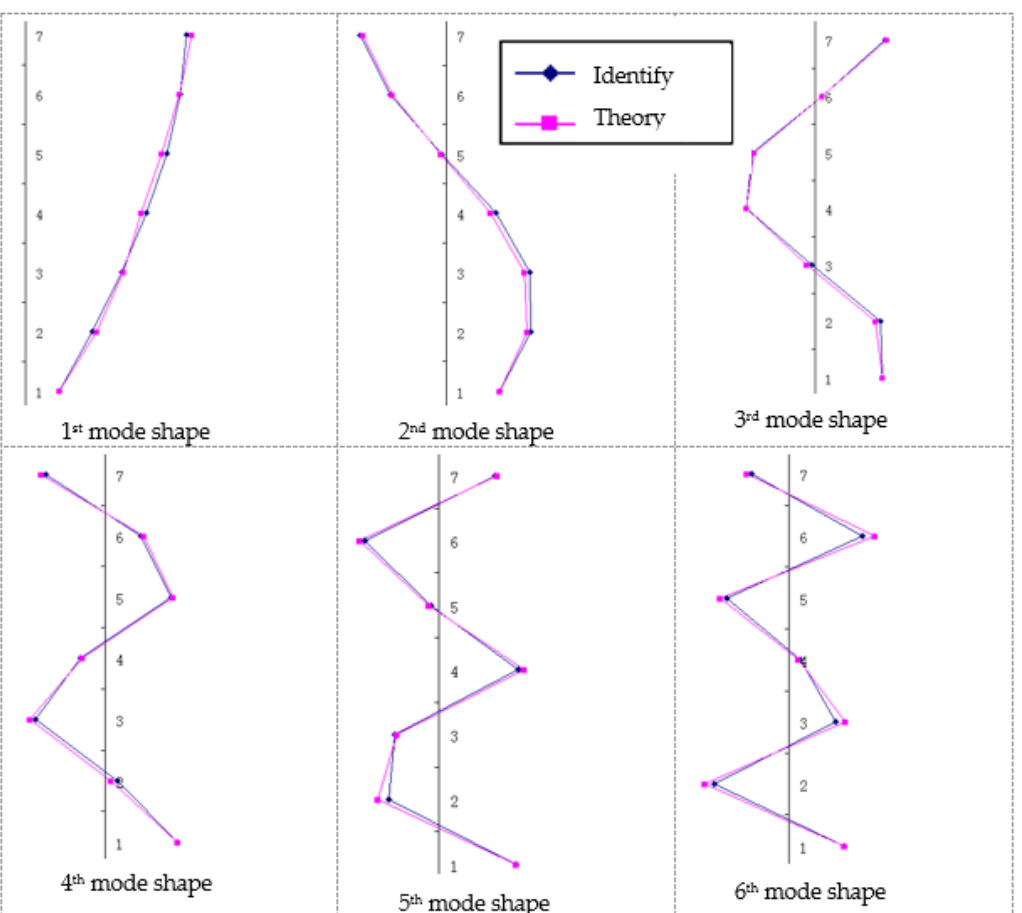
Figure 17. The first six vibration modes identified using the IEMD/ARMA method.